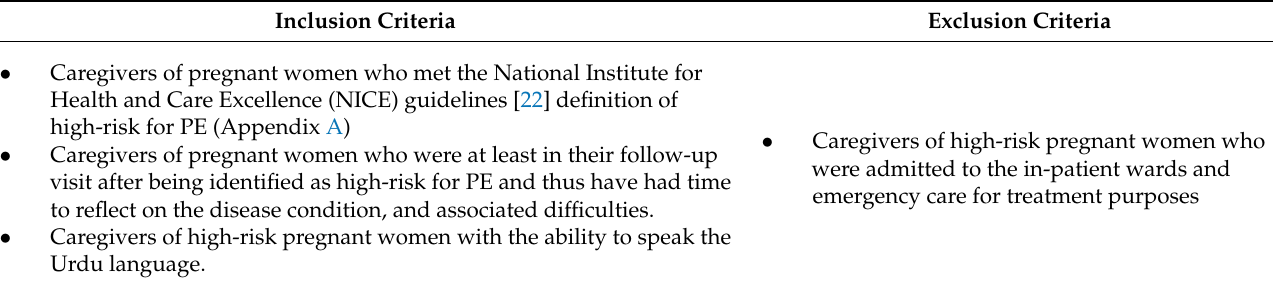
Table 1. Eligibility criteria for caregivers of pregnant women at high-risk for